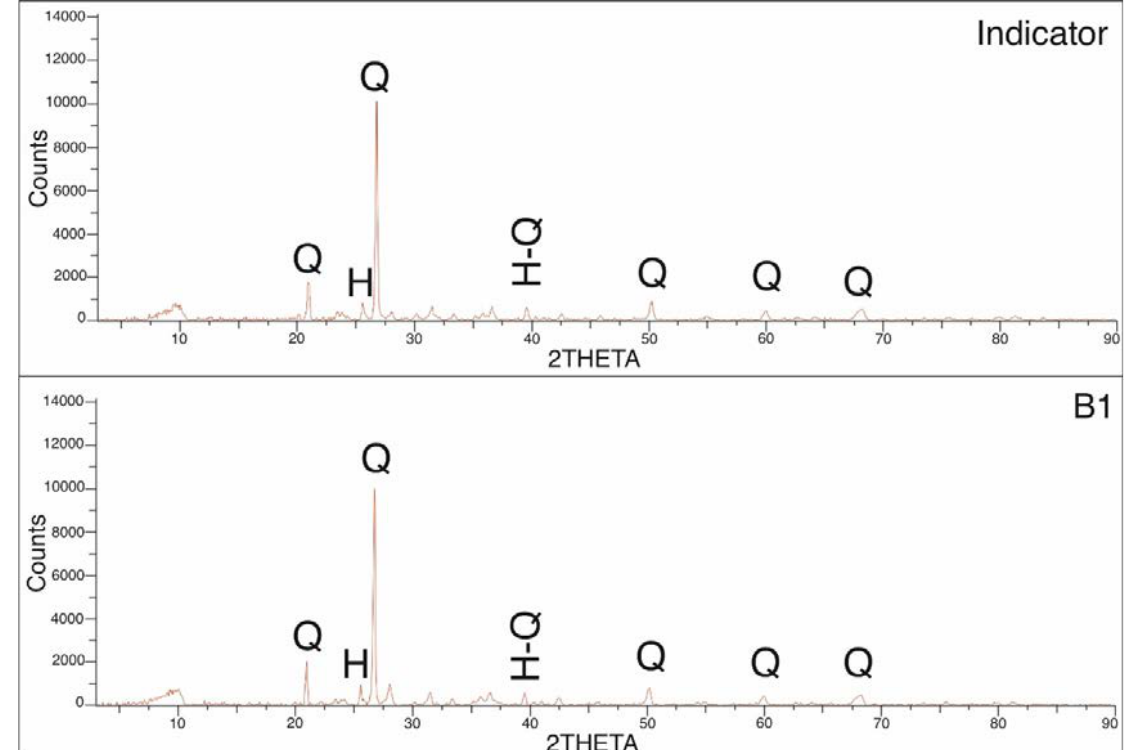
Fig. 6: X-ray diffractograms of the indicator brick sample containing 100% clay, and the B1 sample with 10% sewage sludge.